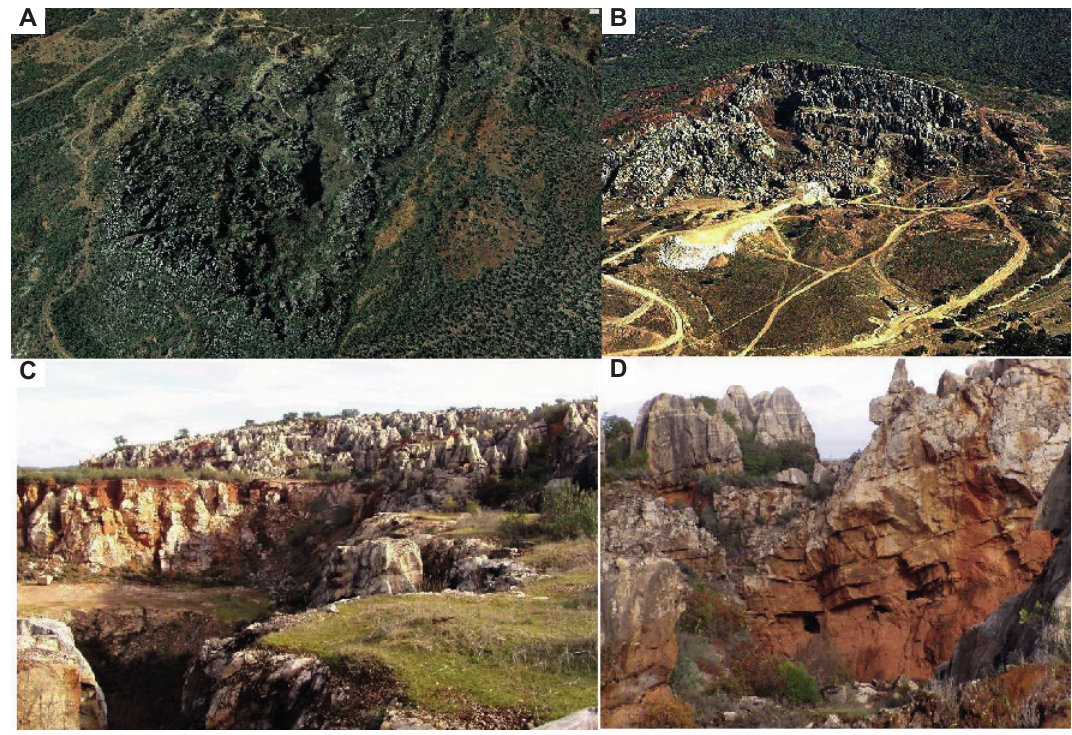
FIGURE 5 . Class 3 Geo-mining Heritage. A and B - the general characteristics of the exhumed area, which was generated by mining activities in Cerro del Hierro, Spain (photo A: Google 2020, photo B: J. Alonso). C and D - features of the exhumed paleogenic paleokarst, with cavities emptied by the extraction